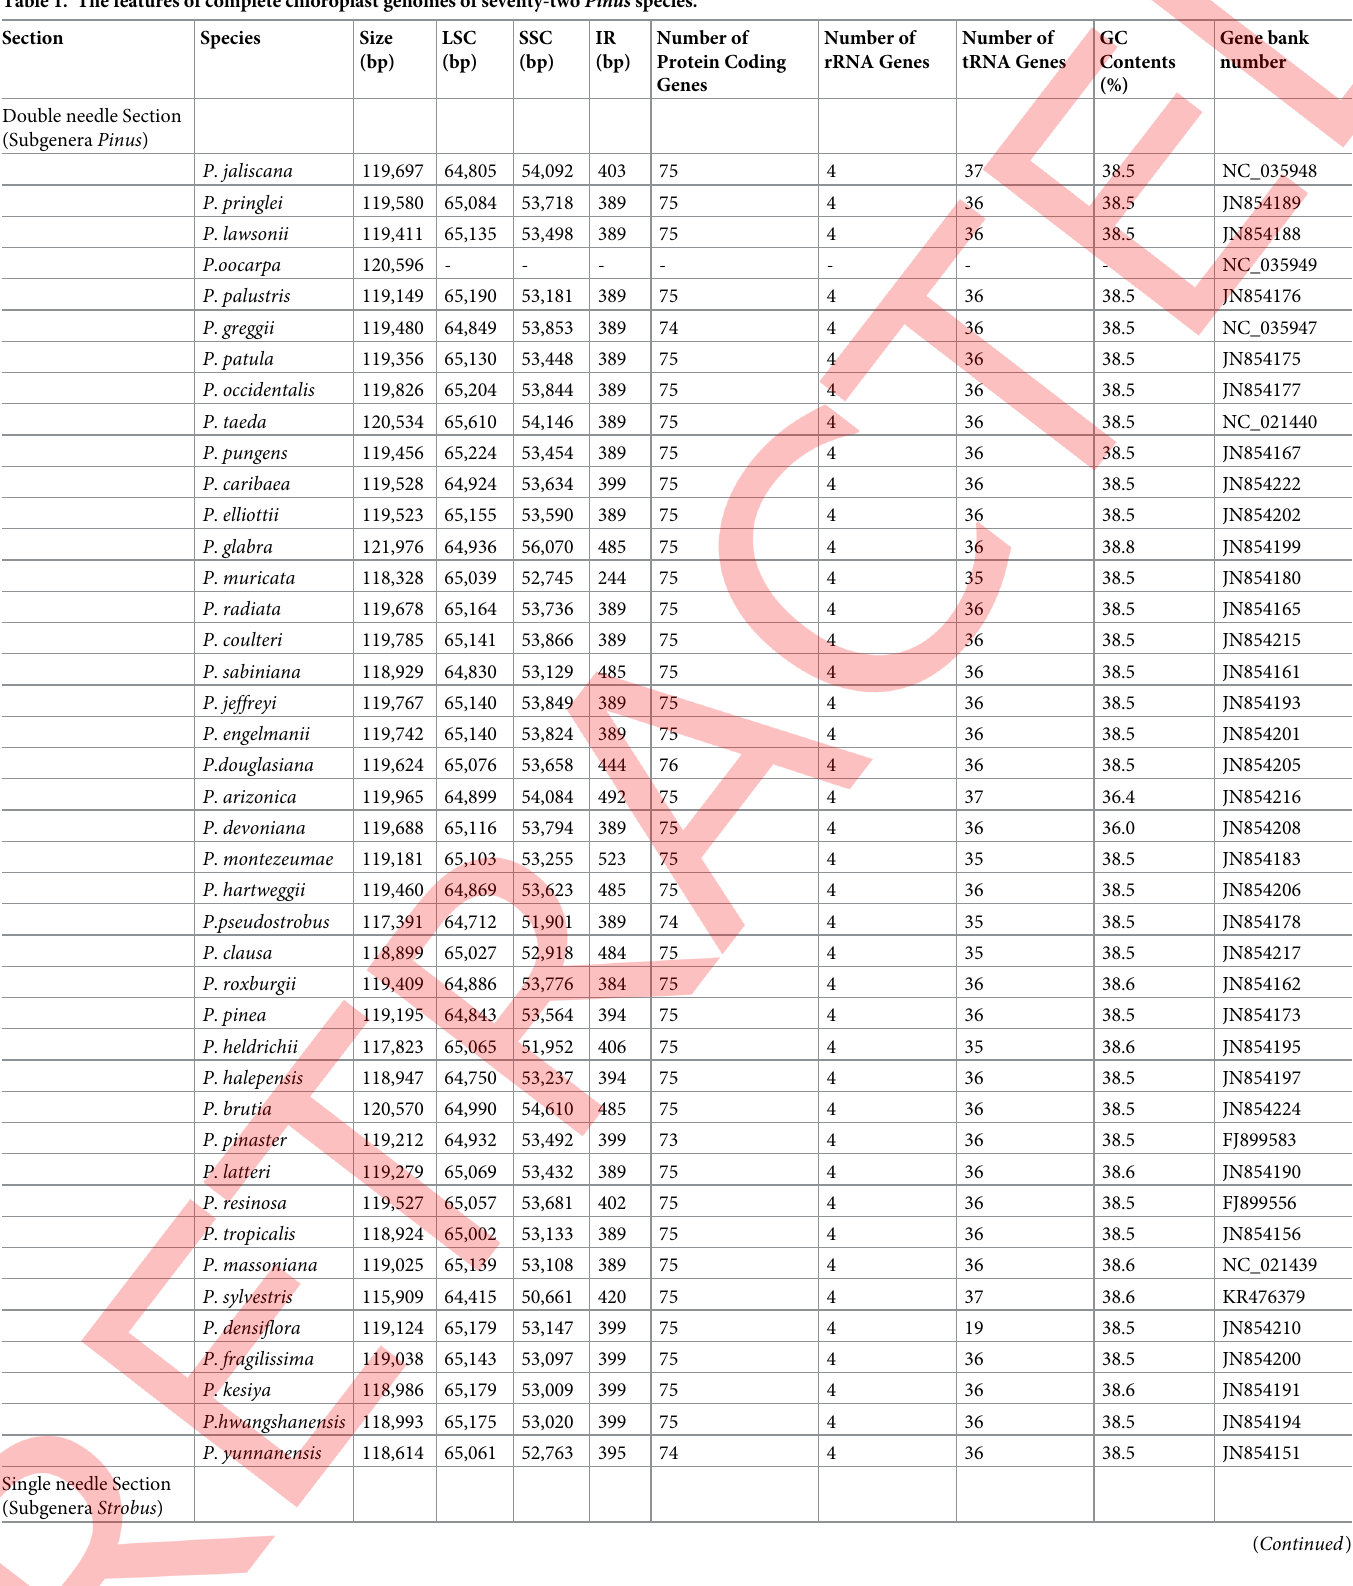
Table 1. The features of complete chloroplast genomes of seventy-two Pinus species. Section